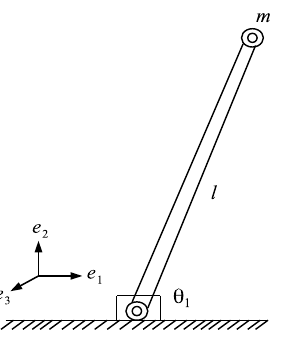
Figure 1. Single degree-of-freedom